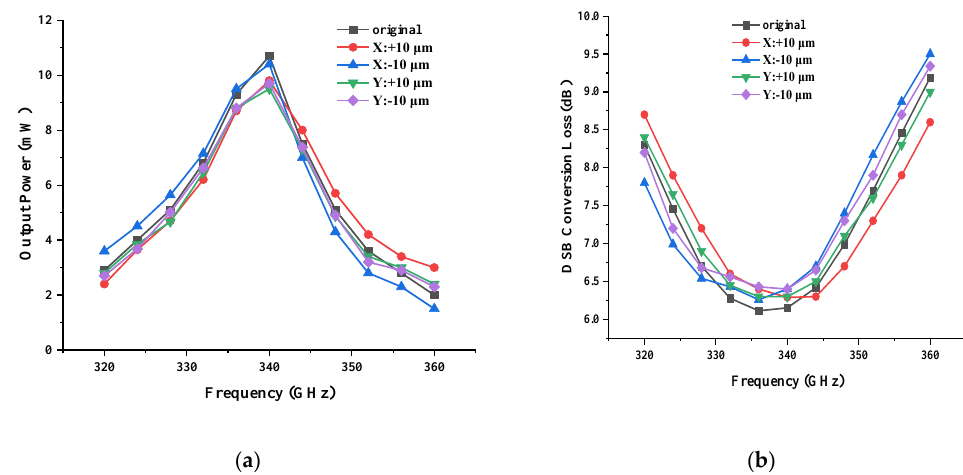
Figure 10. Tolerance analysis simulation results and comparison with original simulation data of ( a ) 0.34 THz tripler and ( b ) 0.34 THz SHM.